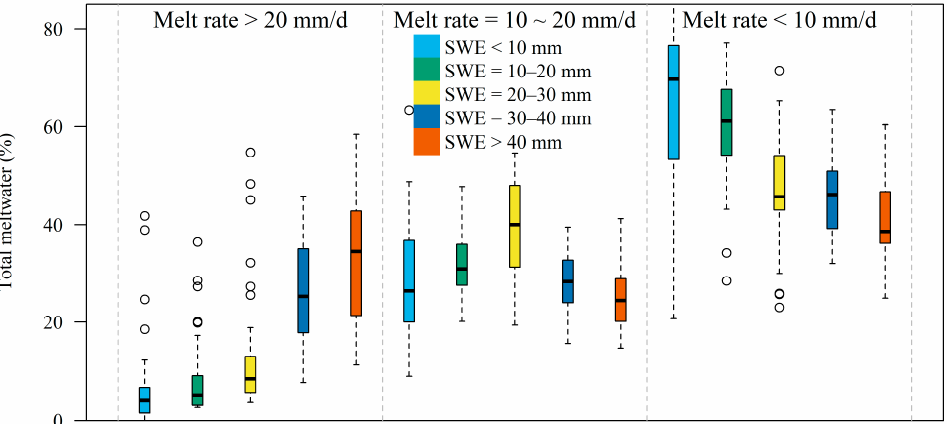
Figure 7. Proportions of meltwater volume produced at different snowmelt rates derived from the passive microwave remote sensing datasets. The percentage contribution to total snowmelt arising from low (<10 mm/day), moderate (10–20 mm/day), and high (>20 mm/day) melting rates was classified according to the historical snowpack depth (color coded; see legend inset). Boxplots show the minimum (lower whisker), quarter (bottom of the box), median (line), three-quarter (top of the box), and maximum (upper whisker) values for each SWE group. Circles are outliers.